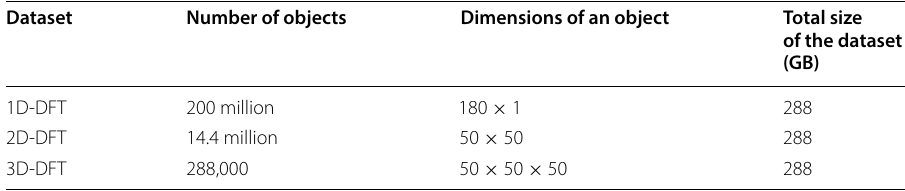
Table 4 Datasets for 1D-, 2D-, and 3D-DFT calculations